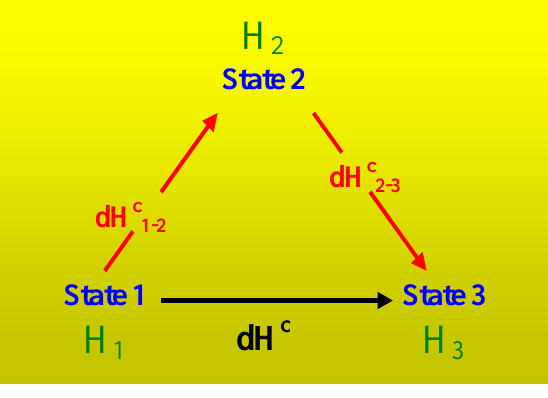
Figure 4. Variation in enthalpy between the different states of a differential concentration experiment of